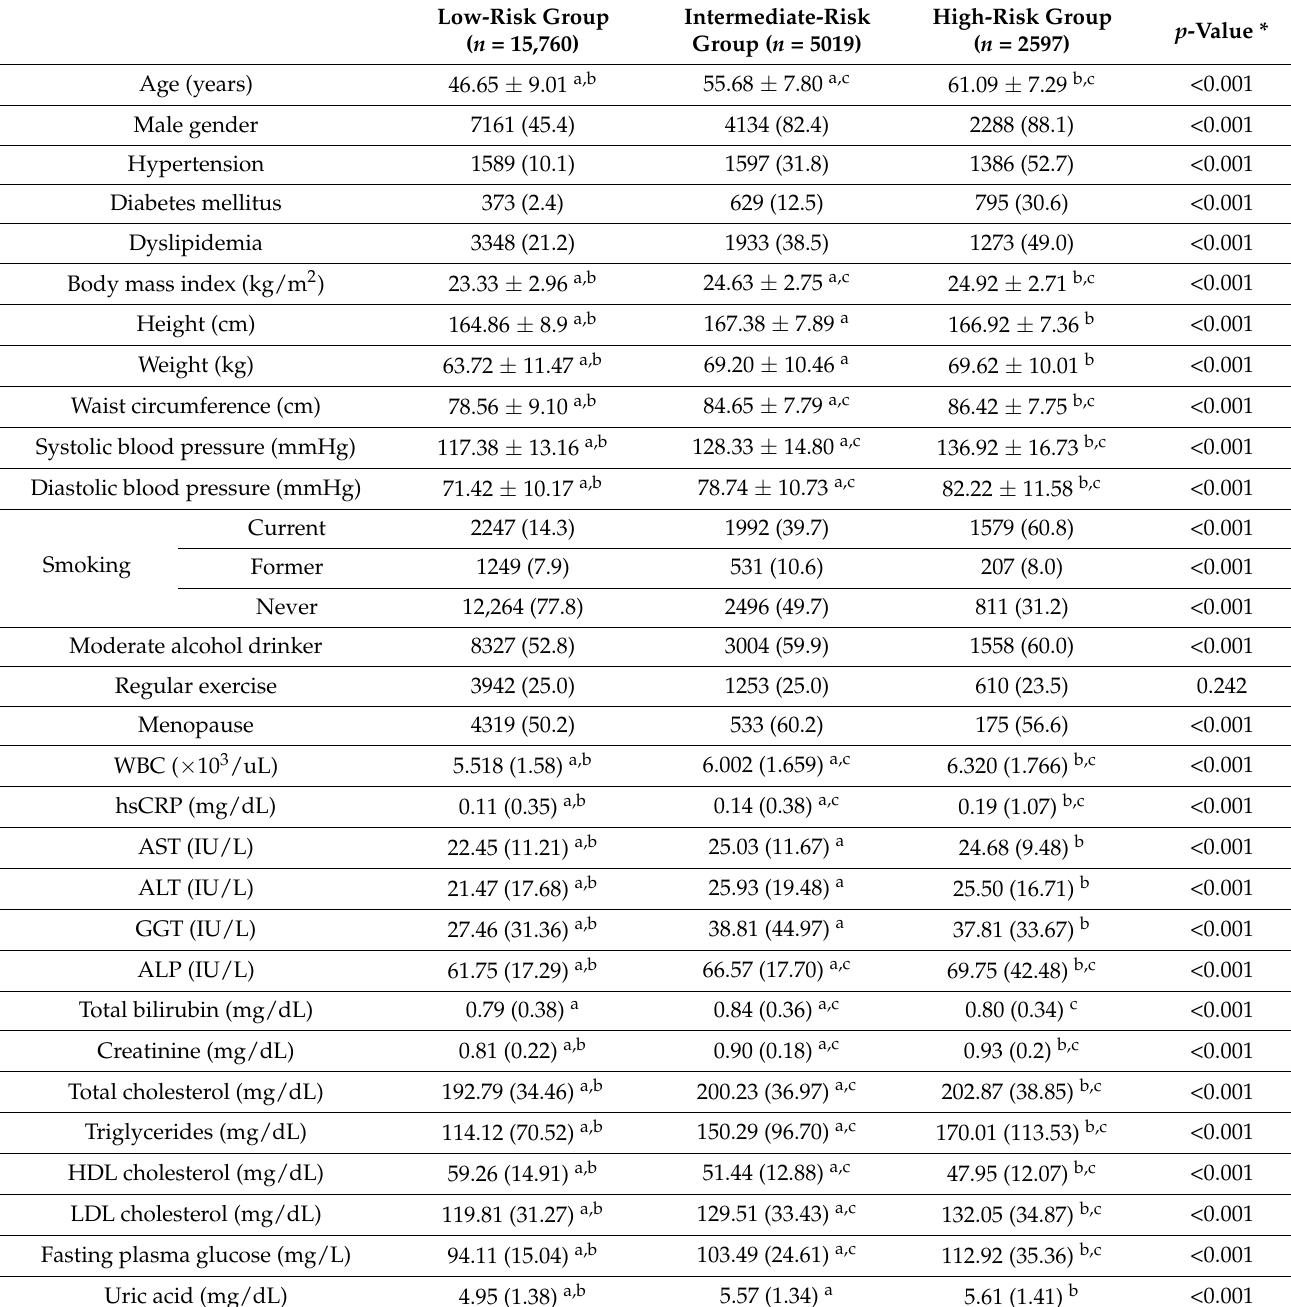
Table 1. Baseline demographic, clinical, and biochemical characteristics of the study subjects according to CVD risk